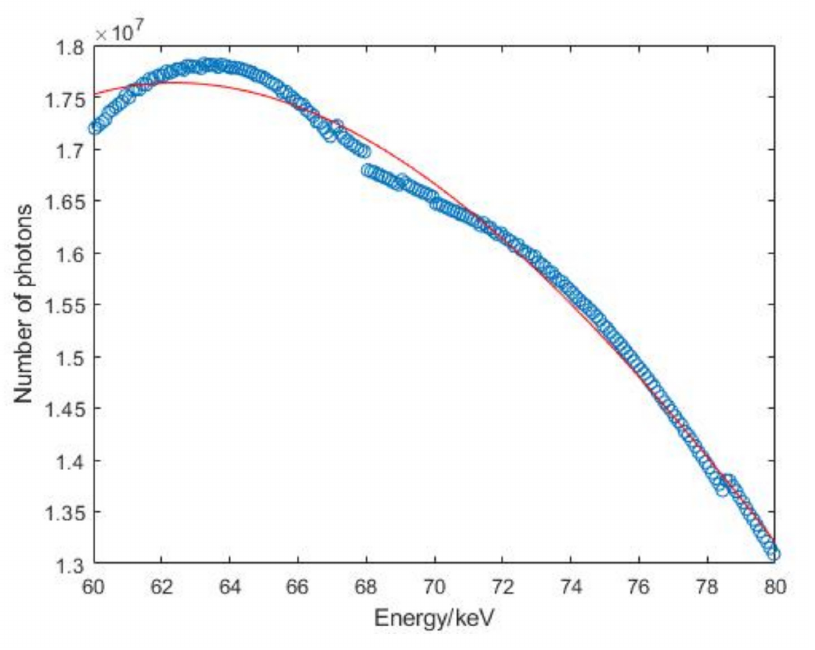
Figure 11. The result of cubic function fitting energy